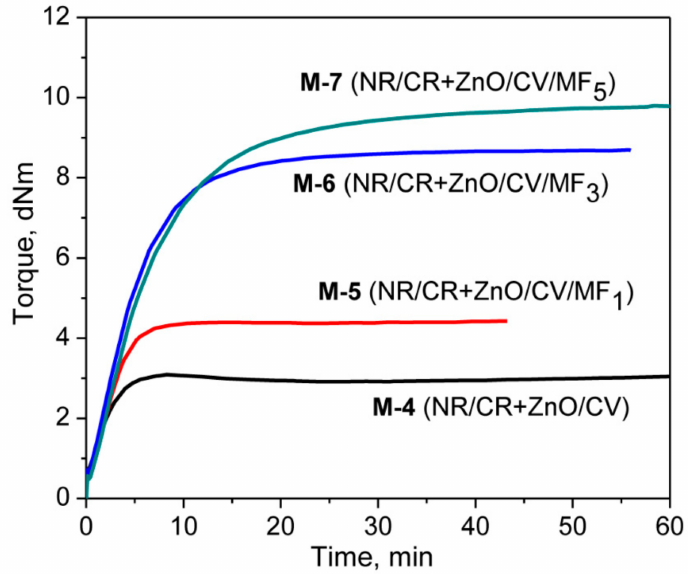
Figure 5. Cure curves of the mixes M-4, M-5, M-6, and